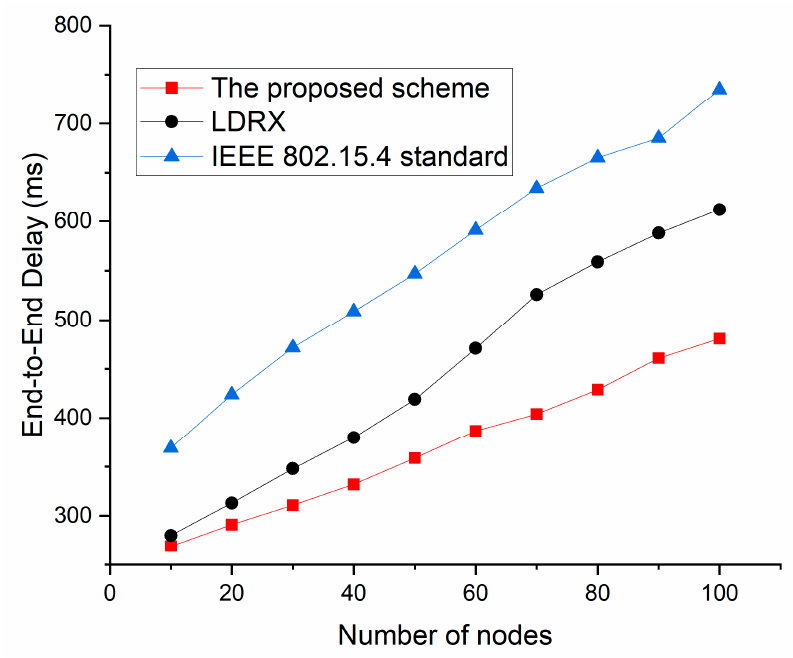
Figure 10. End ‐ to ‐ end delay as a function of the number of devices. Figure 10. End-to-end delay as a function of the number of